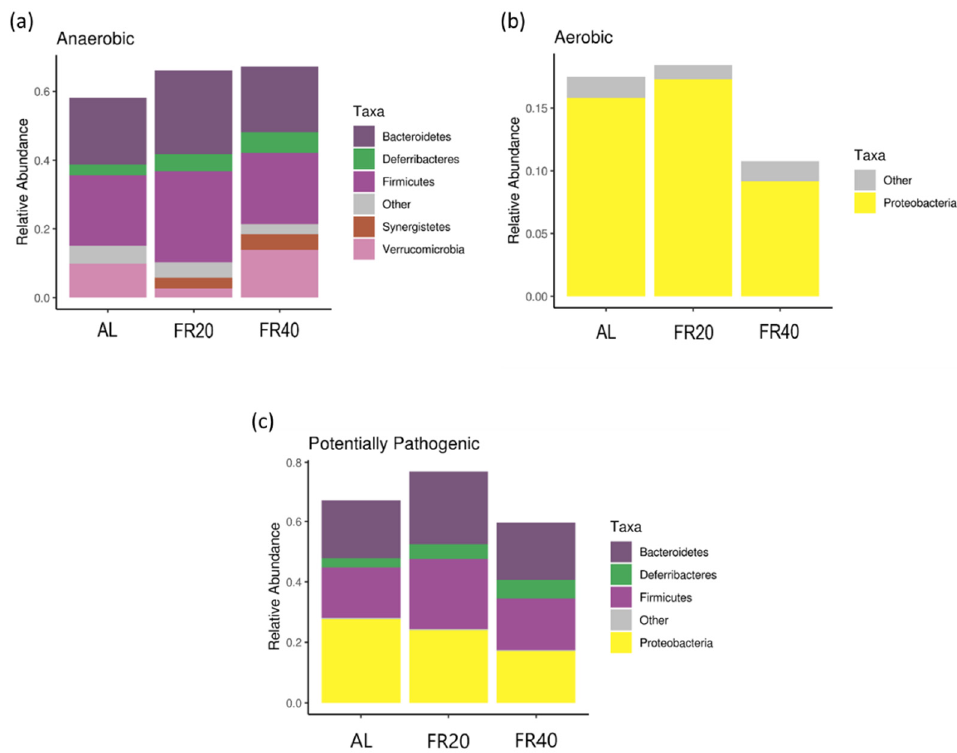
Figure 6. Microbial phenotype in cecum: ( a ) anaerobic microbiota; ( b ) aerobic microbiota; and ( c ) pathogenic microbiota. AL: ad libitum with basal diet; FR20: basal diet with 20% feed restriction; FR40: basal diet with 40% feed restriction.